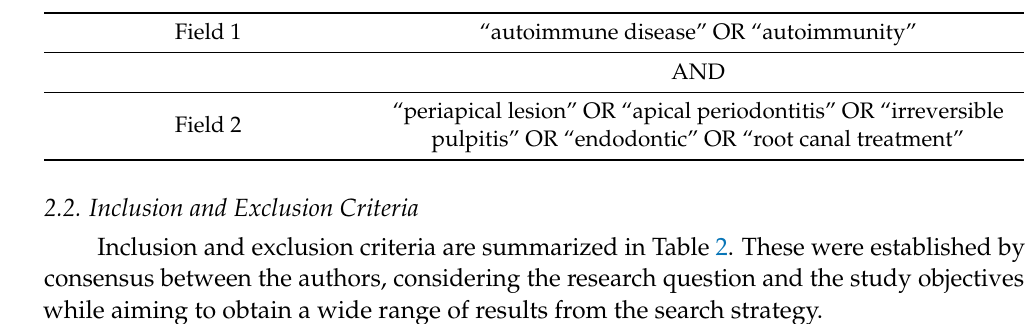
Table 1. Search strategy.